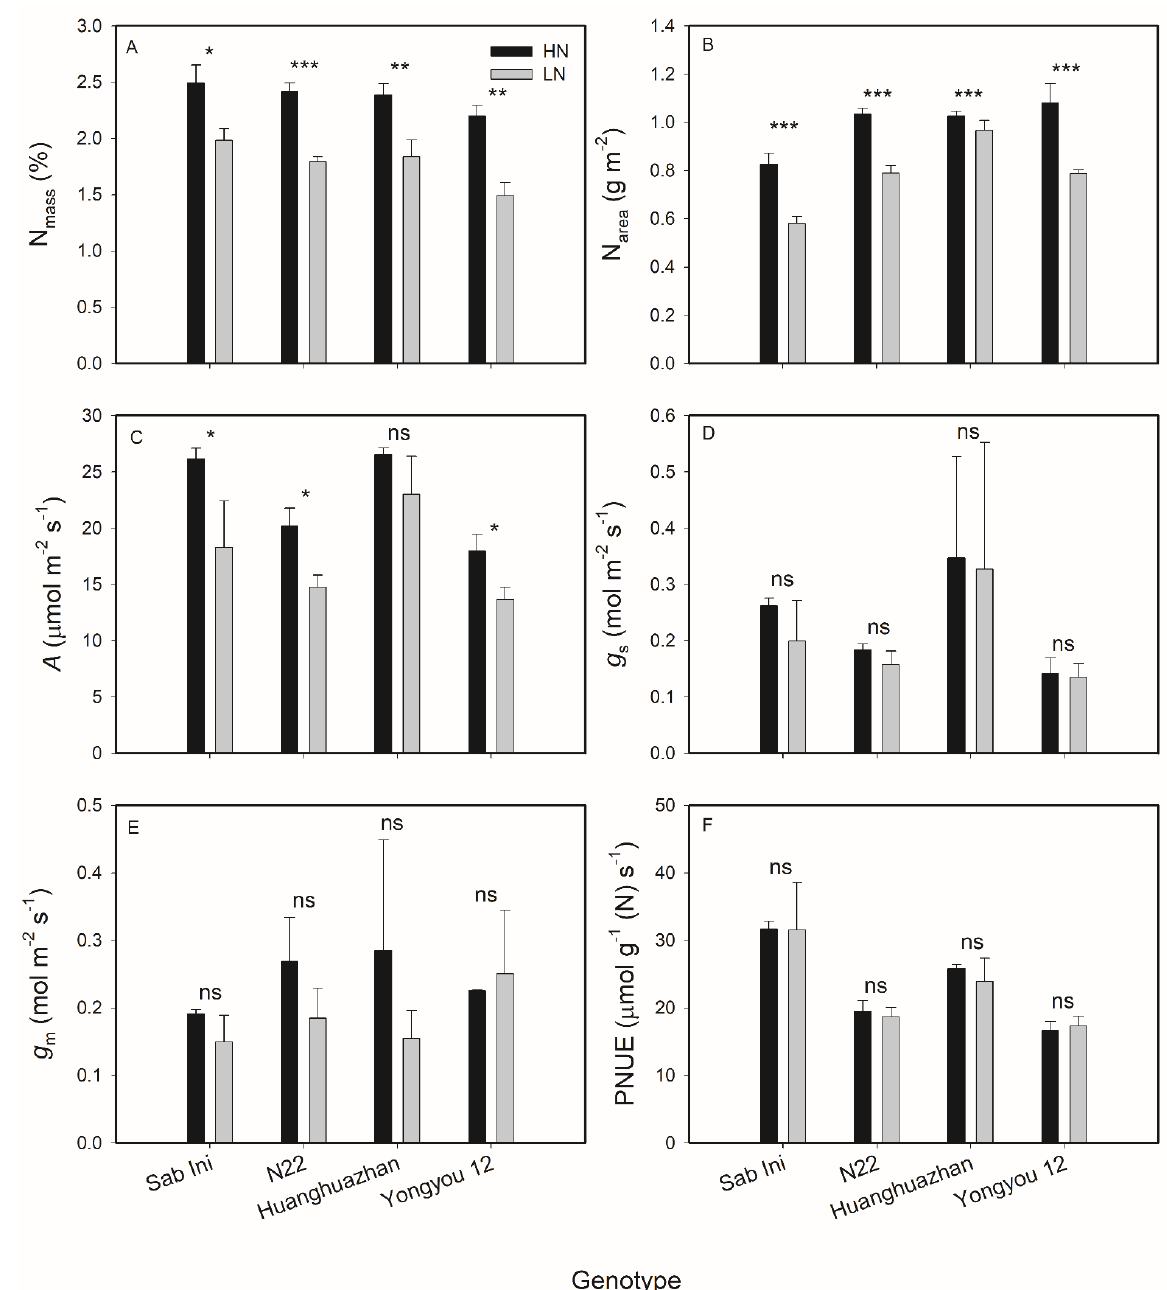
Figure 1. Variations in mass-based leaf nitrogen content (N mass , ( A )), area-based leaf nitrogen content (N area , ( B )), leaf net photosynthetic rate ( A , ( C )), stomatal conductance ( g s , ( D )), mesophyll conductance ( g m , ( E )), and photosynthetic nitrogen use efficiency (PNUE, ( F )) in the flag leaves of the four rice genotypes between high (HN) and low (LN) N supply. Parameters were compared between HN and LN for each genotype based on the least significant difference (LSD) test at the 0.05 probability level. *, p < 0.05; **, p < 0.01; ***, p < 0.001; ns, non-significant.